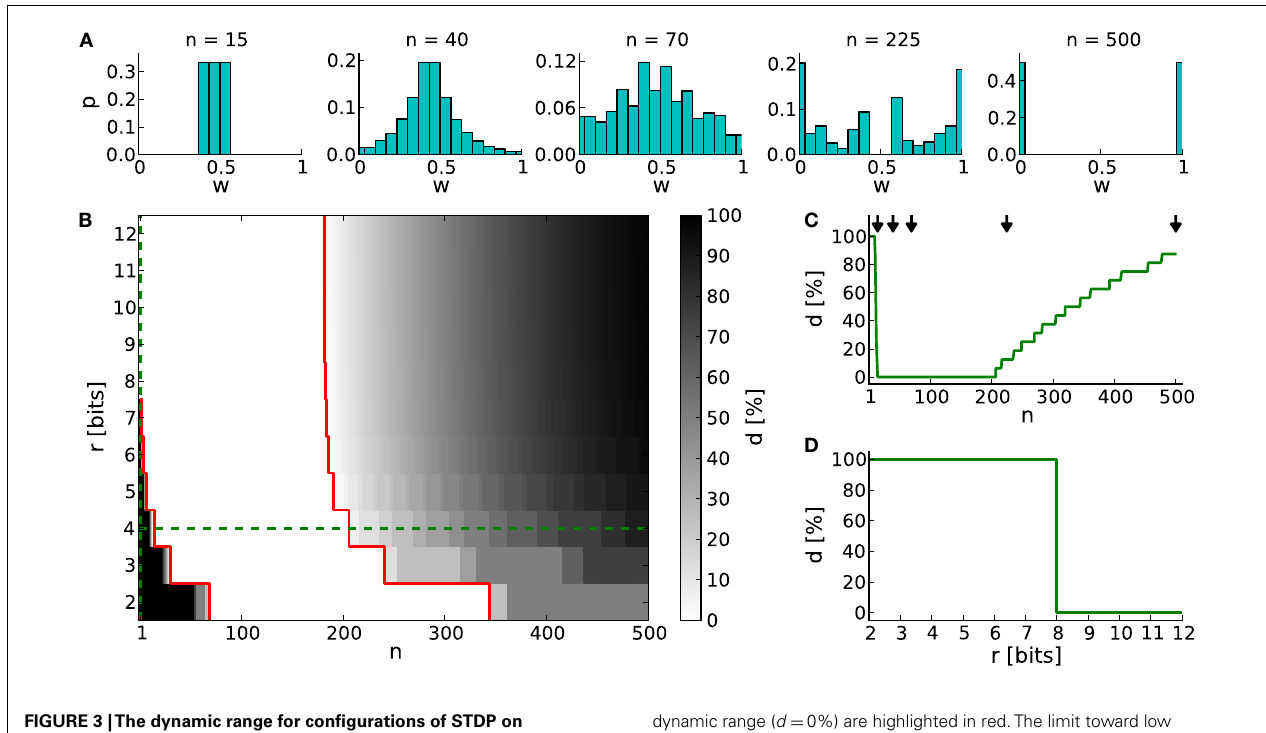
FIGURE 3 |The dynamic range for configurations of STDP on discrete weights. (A) Equilibrium weight distributions for a 4-bit weight resolution: Intermediate discrete weights partly project to themselves ( n = 15).The equilibrium weight distribution widens with an increasing number of SSPs ( n = 40 and 70). For a large number of SSPs ( n = 225 and 500) the intermediate discrete weights do not receive projections from others. (B) Percentage of dead discrete weights d .The limits of the